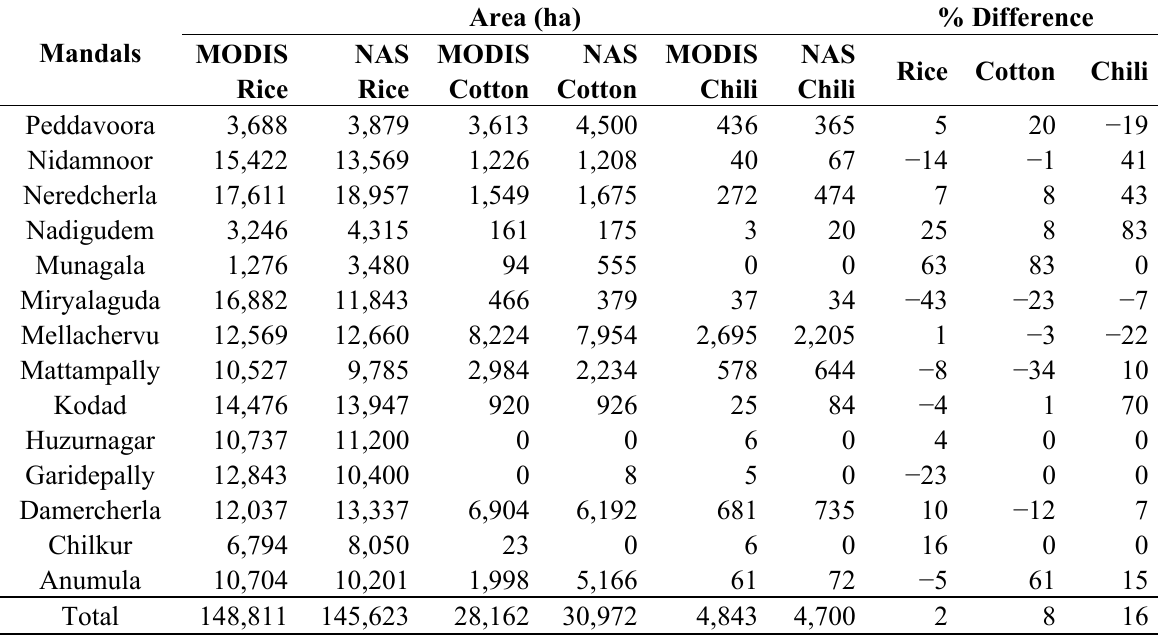
Table 3. Comparison of IRS- and MODIS-derived statistics and national agriculture statistics (NAS) for Nalgonda zone during the years 2005–2006. Area Mandals